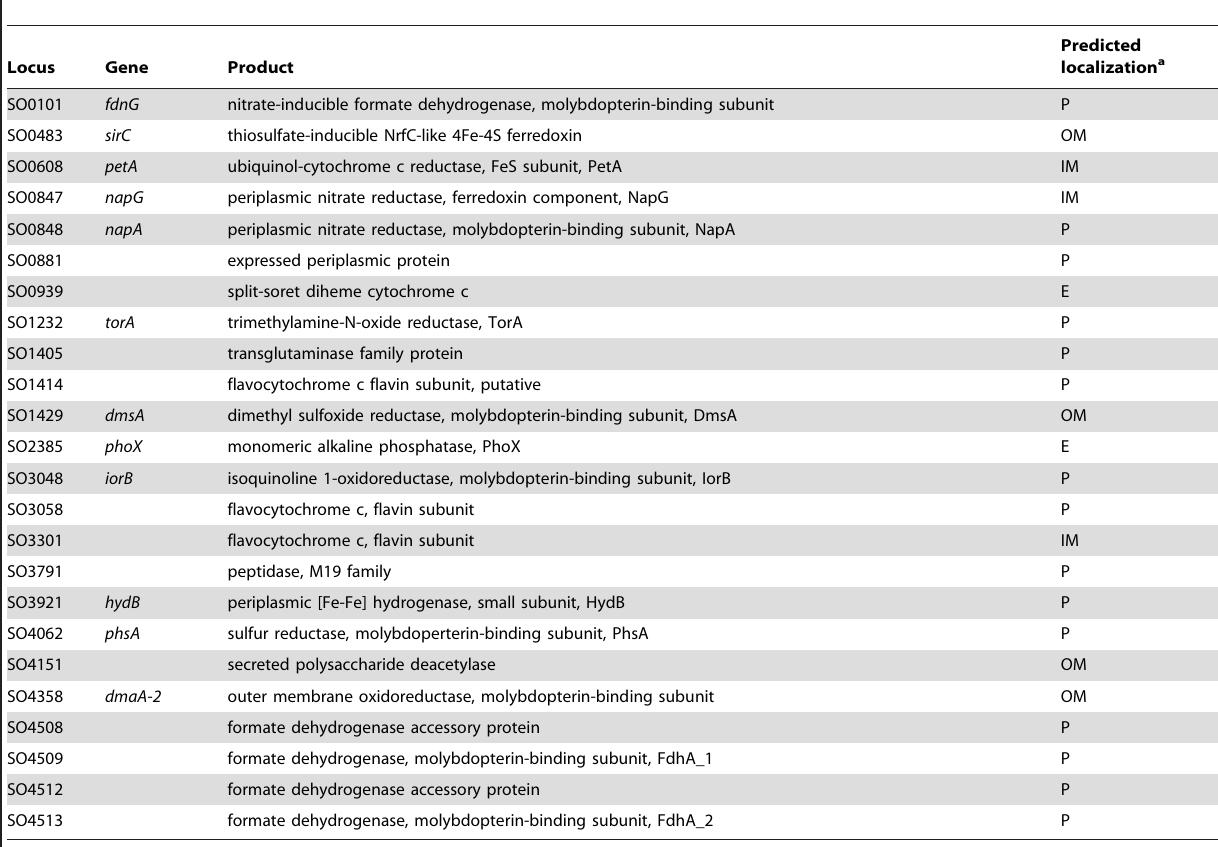
Table 1. Refined putative Tat substrates in S. oneidensis .